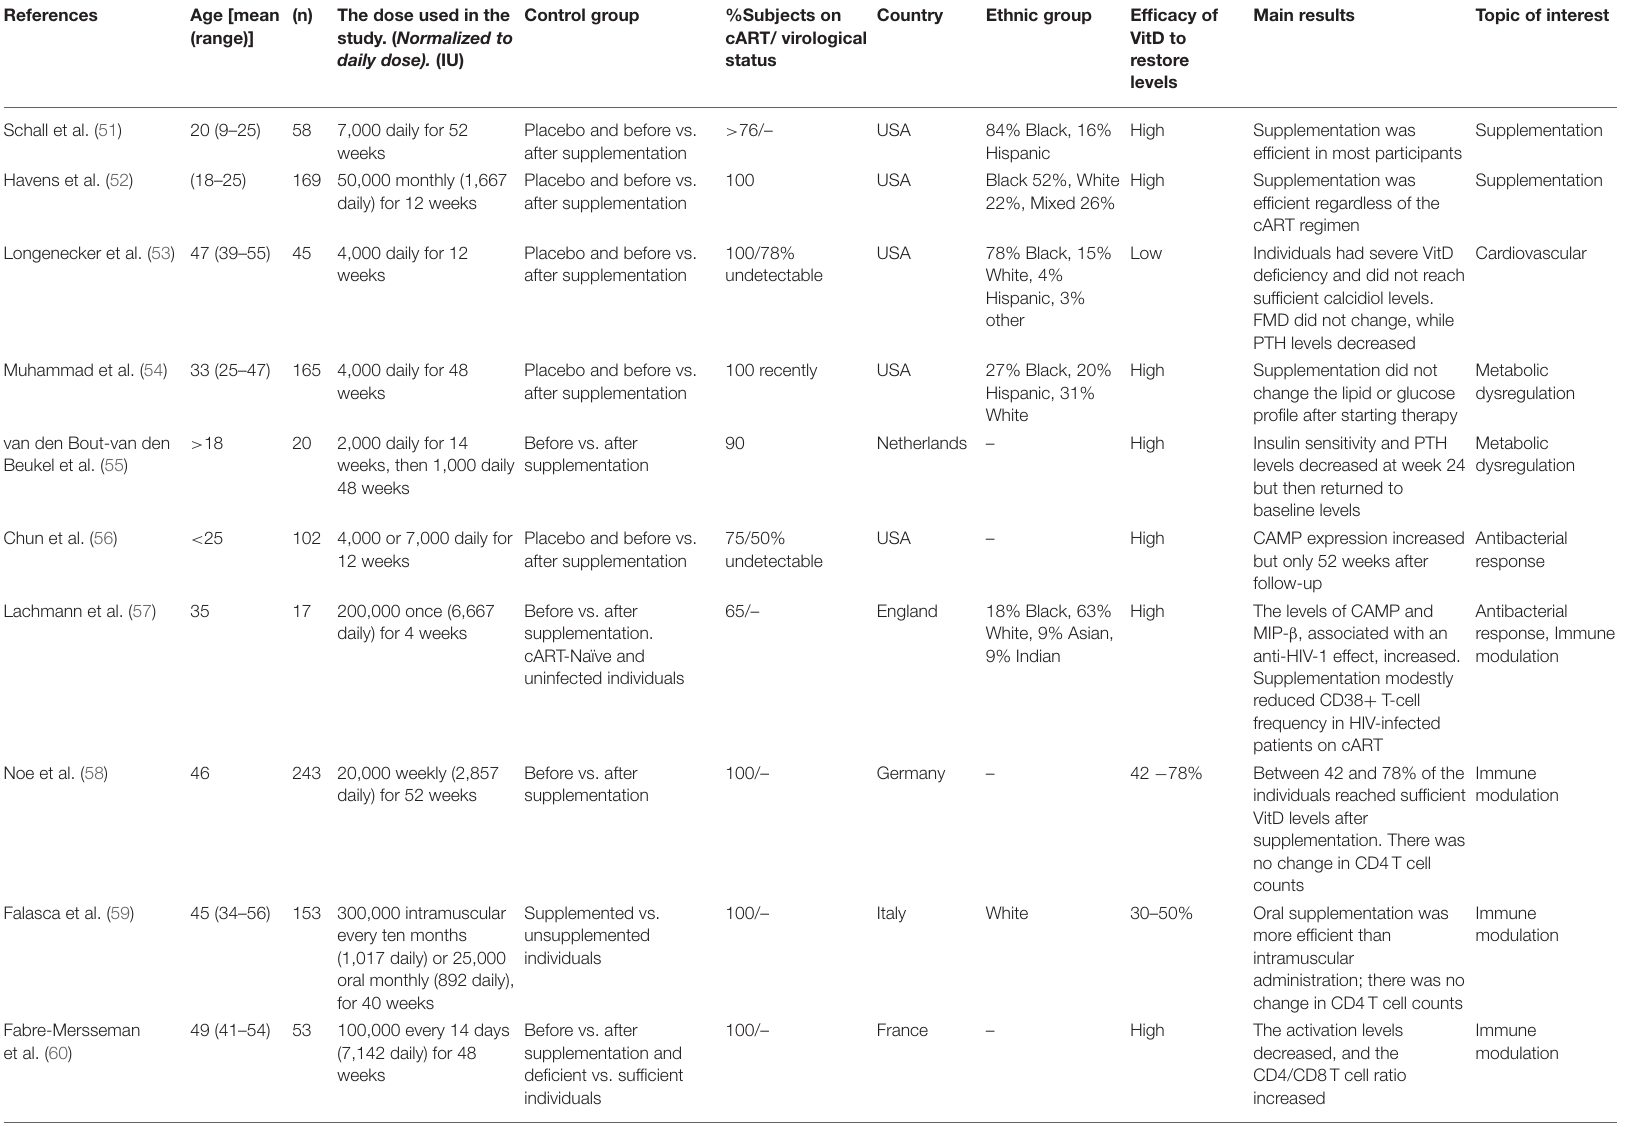
TABLE 1 | Vitamin D supplementation studies in HIV-1 infected